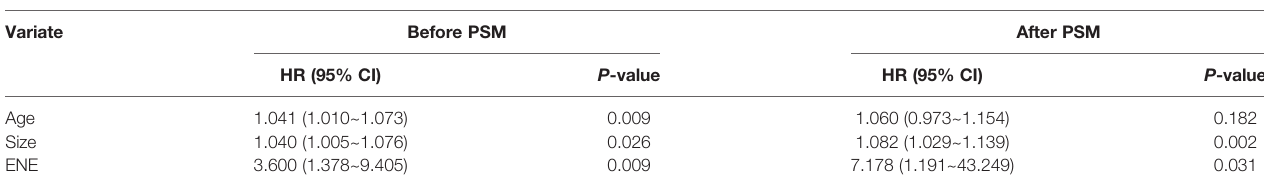
TABLE 5 | Cox regression analysis of patients before and after PSM.